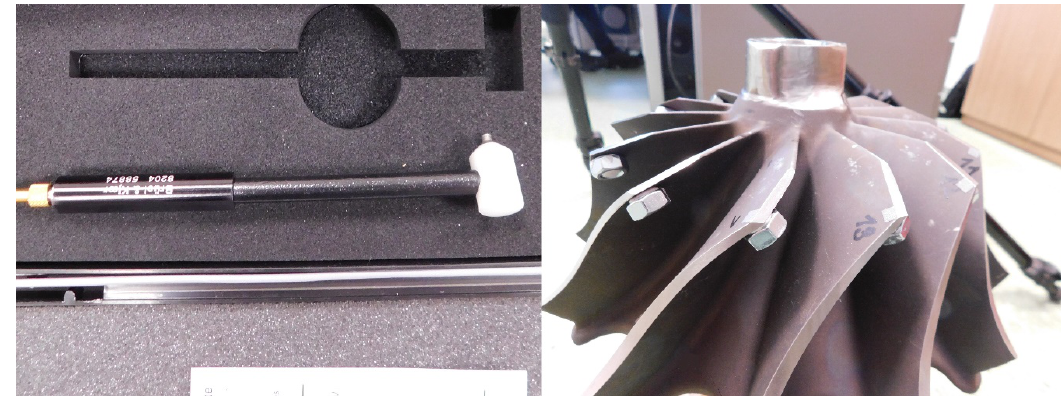
Figure 4. Turbocharger turbine wheel with additional masses on blades and the used modal hammer.